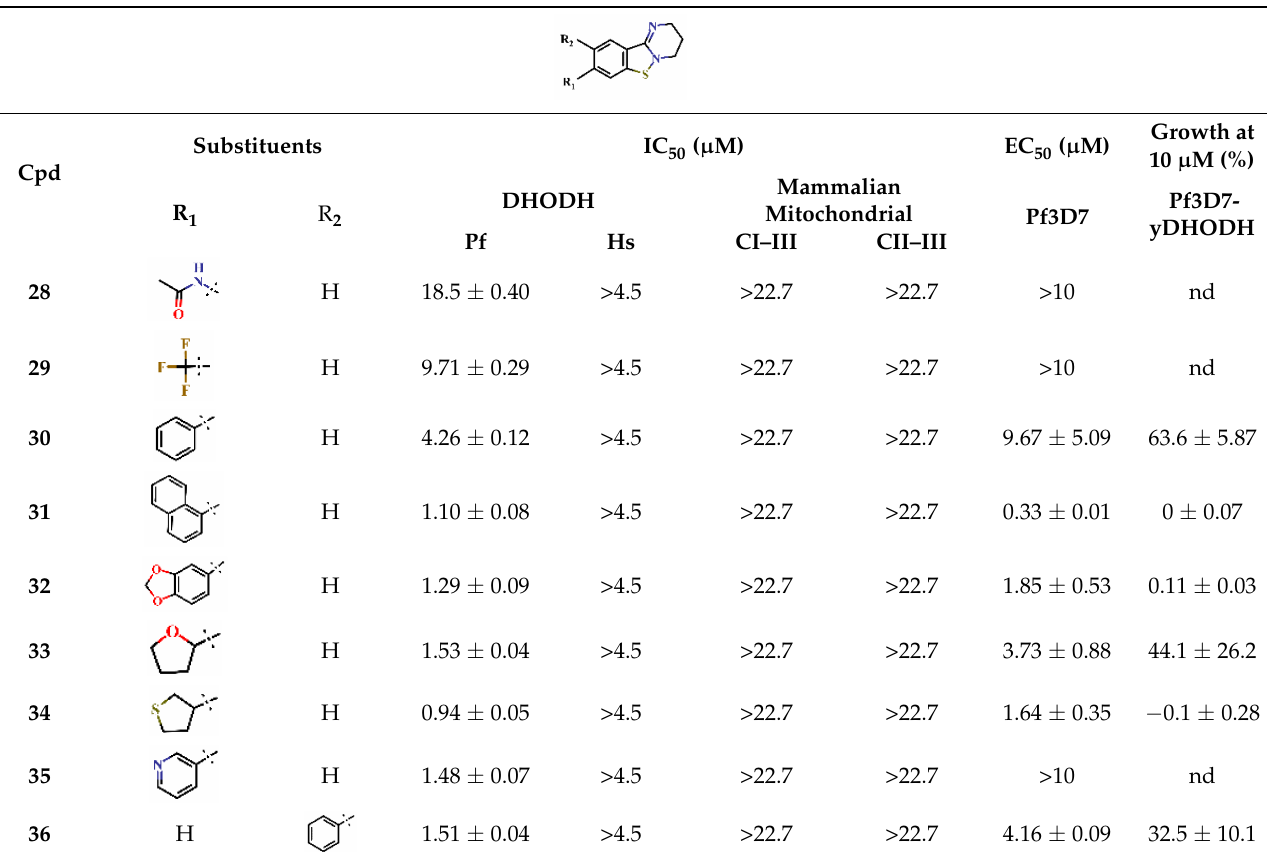
Table 3. Antimalarial activity of DBIP